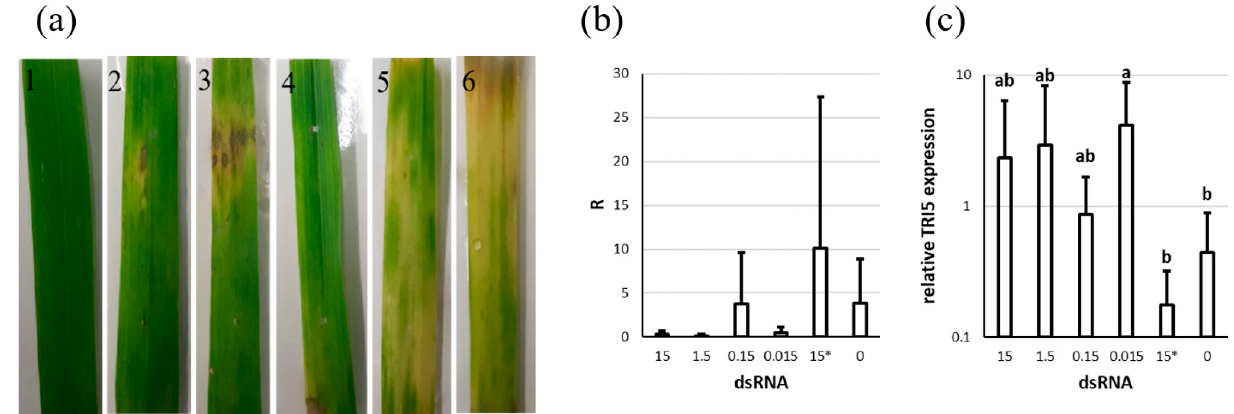
Figure 6. The influence of different concentrations of dsTRI5RNA on F. culmorum growth and TRI5 expression on detached wheat leaves. ( a ) Representative pictures: 1: 15 µg, 2: 1.5 µg, 3: 0.15 µg, 4: 0.015 µg dsTRI5RNA, respectively; 5: 15 µg of non-target dsRNA (control); 6: water (control). ( b ) Quantification of F. culmorum in the leaves based on EF1A relative to wheat Act . R calculated with formula (2). ( c ) Expression of the TRI5 gene in F. culmorum growing on the leaves. Expression is relative to the control sample, using EF1A as a reference gene. Numbers on x-axes are amounts in µg of dsRNA, * indicates non-target dsRNA. The graph shows the means and standard deviations of three biological replicates or six leaves for each treatment. Letters above the columns indicate statistical significance; p -value ≤ 0.05.